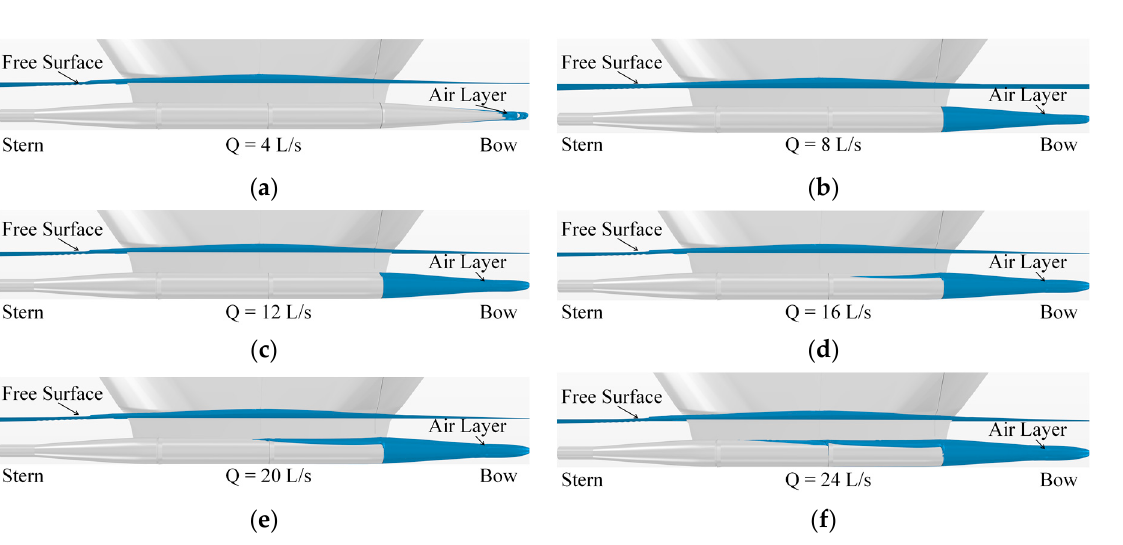
( f ) Figure 8. Air layer distribution with air injected from location L2: ( a ) Air fl ow rate Q = 4 L/s; ( b ) Air fl ow rate Q = 8 L/s; ( c ) Air fl ow rate Q = 12 L/s; ( d ) Air fl ow rate Q = 16 L/s; ( e ) Air fl ow rate Q = 20 L/s; ( f ) Air fl ow rat e Q = 24 L/s.